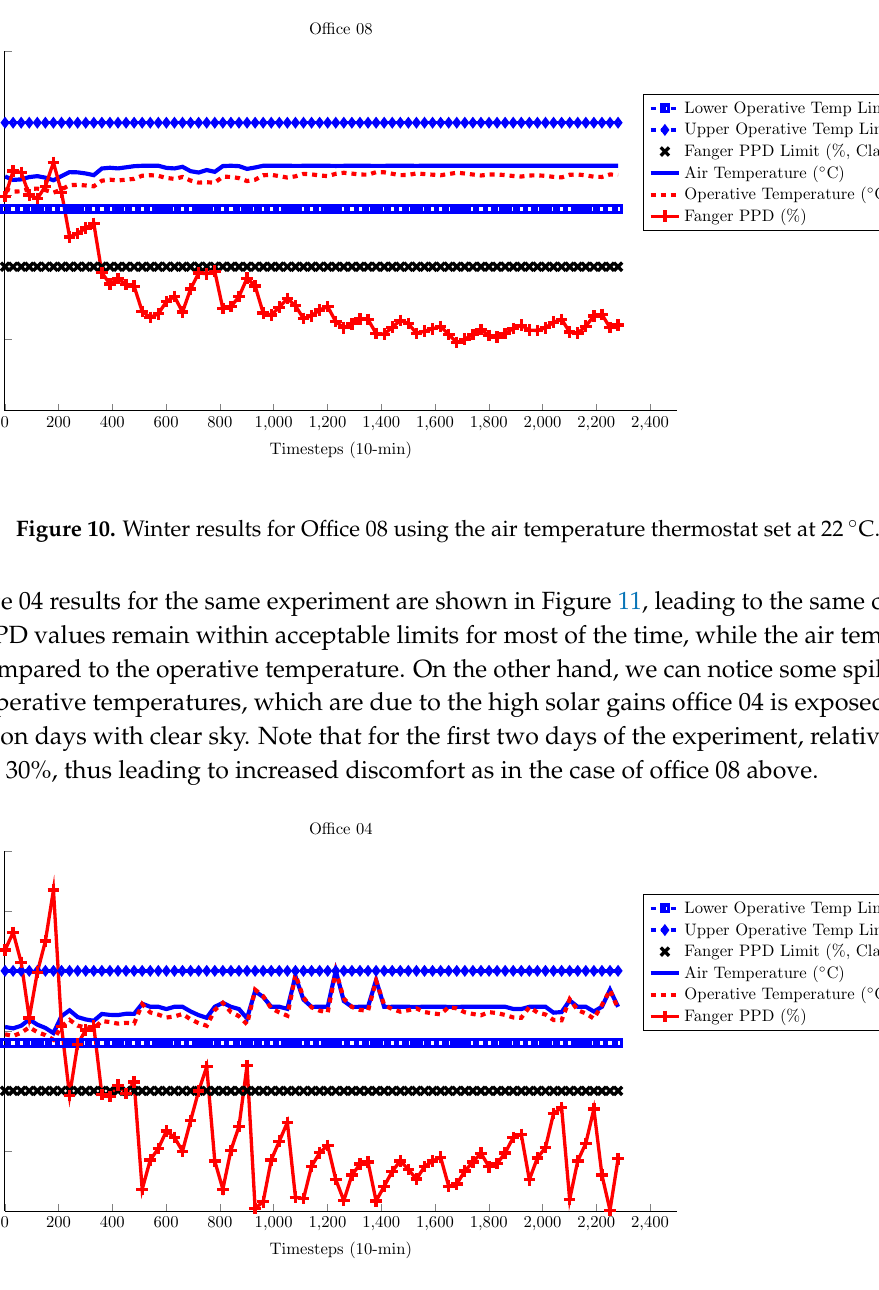
Figure 11. Winter results for office 04 using air temperature thermostat set at 22 ◦